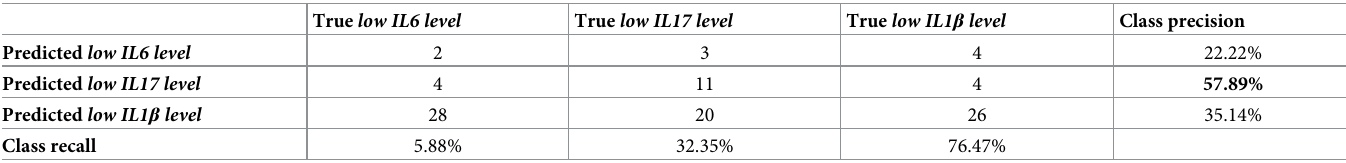
Table 4. Performance parameters of classification model targeting three labels low IL6 level vs. low IL17 level vs. low IL1 β level independently. Accuracy